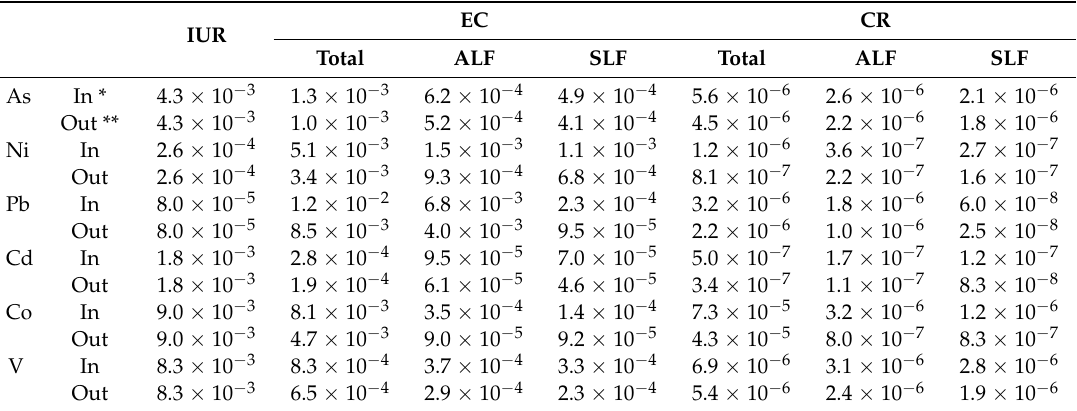
Table 5. Carcinogenic risks to adults from toxic elements in the indoor/outdoor <3.3 µ m fractions ( n = 10).